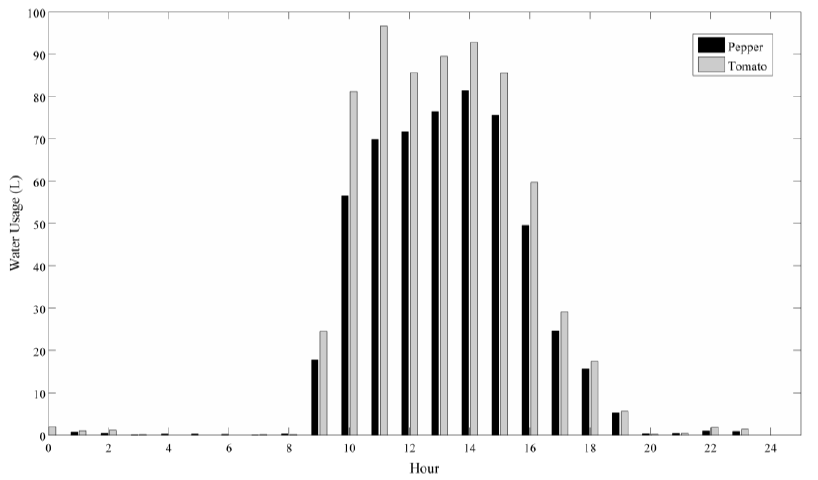
Figure 3. Total hourly water consumption by crop.